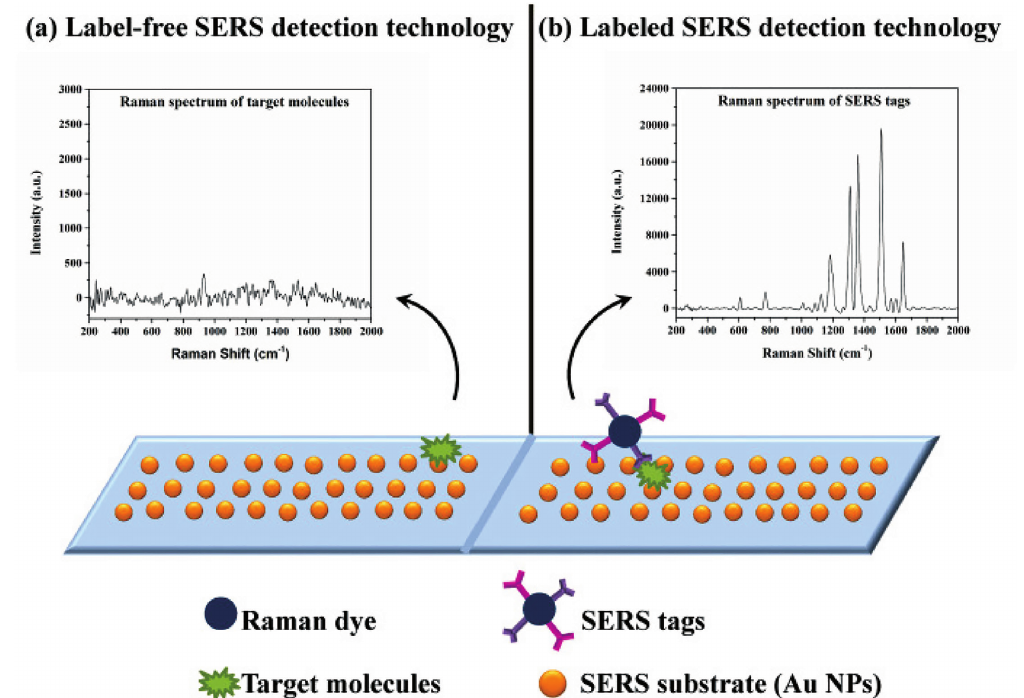
Figure 2: Schematic diagram of (a) label-free SERS detection and (b) labeled SERS detection Reprinted with permission from Ref.